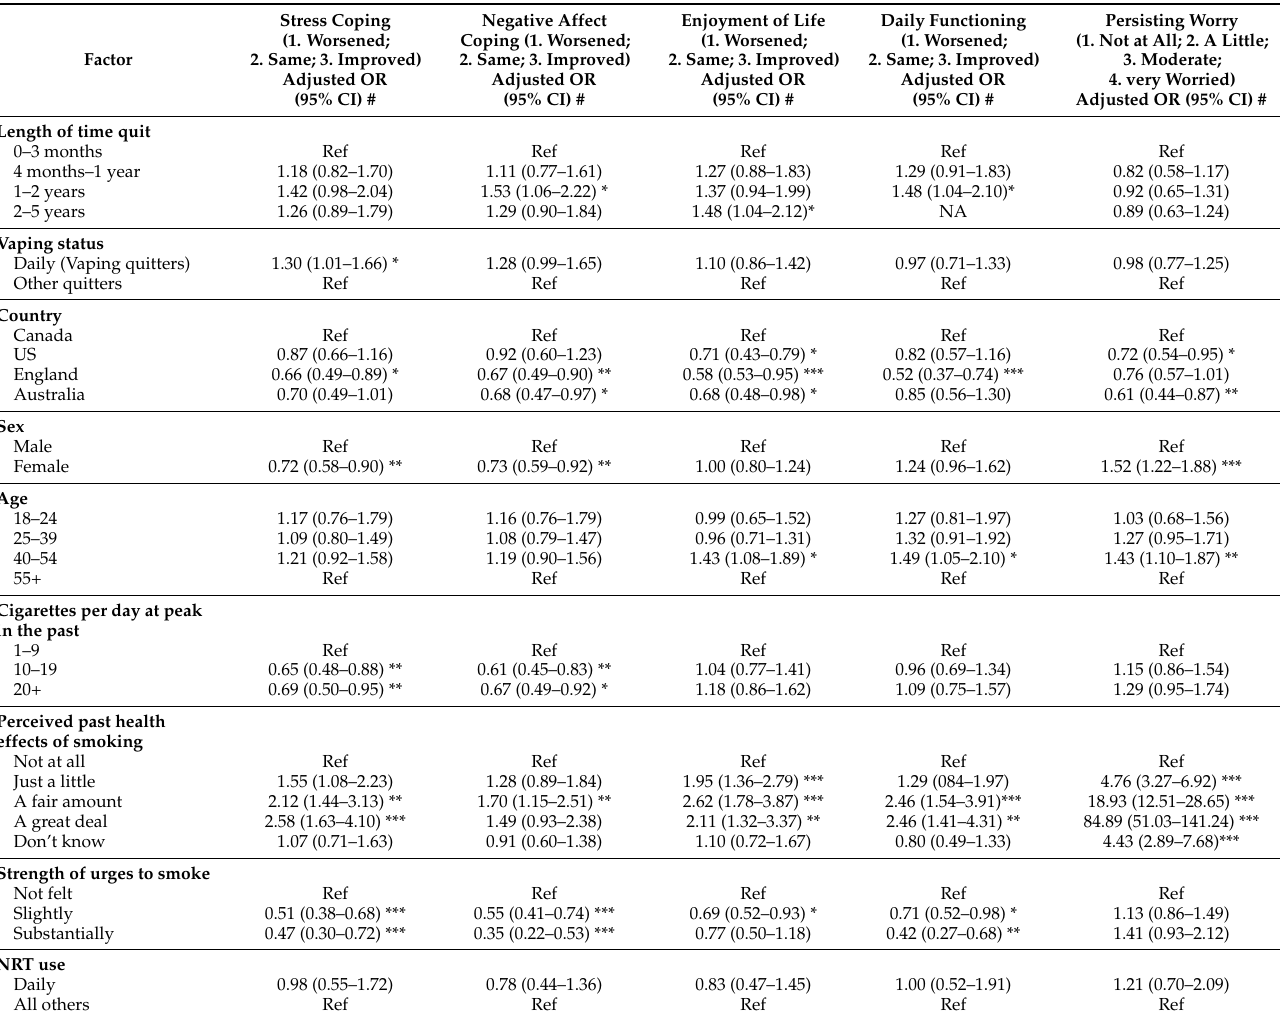
Table 4. Associations between perceived effects of quitting smoking and length of time quit and other variables—ordered logistic regression